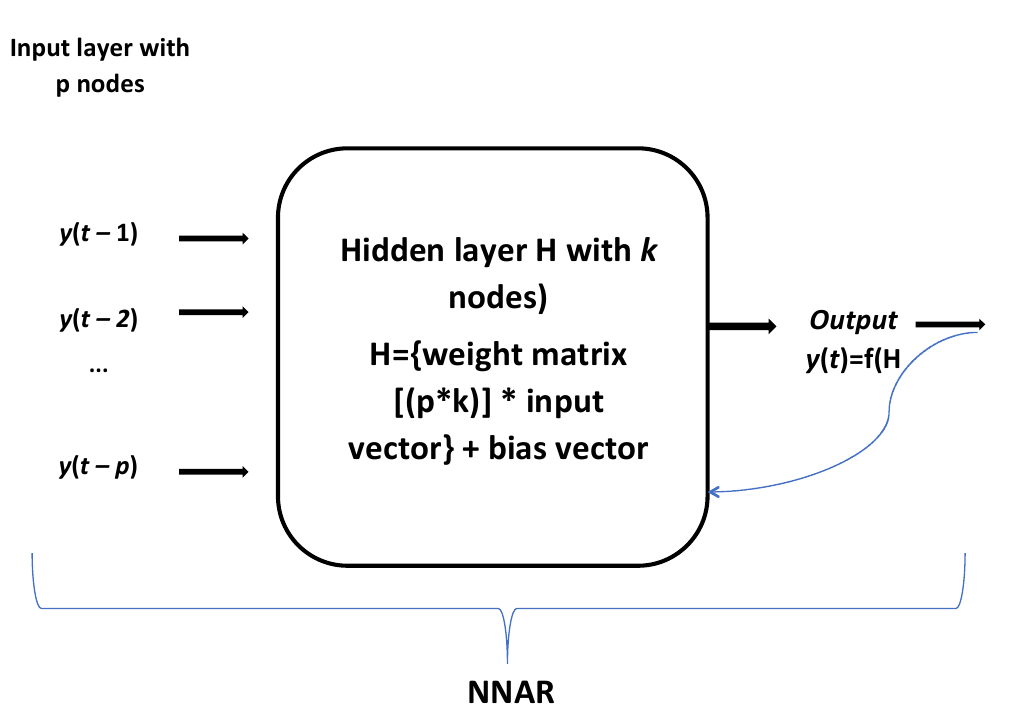
Figure 7. General structure of the nonlinear autoregressive neural network (NNAR) with one hidden layer.